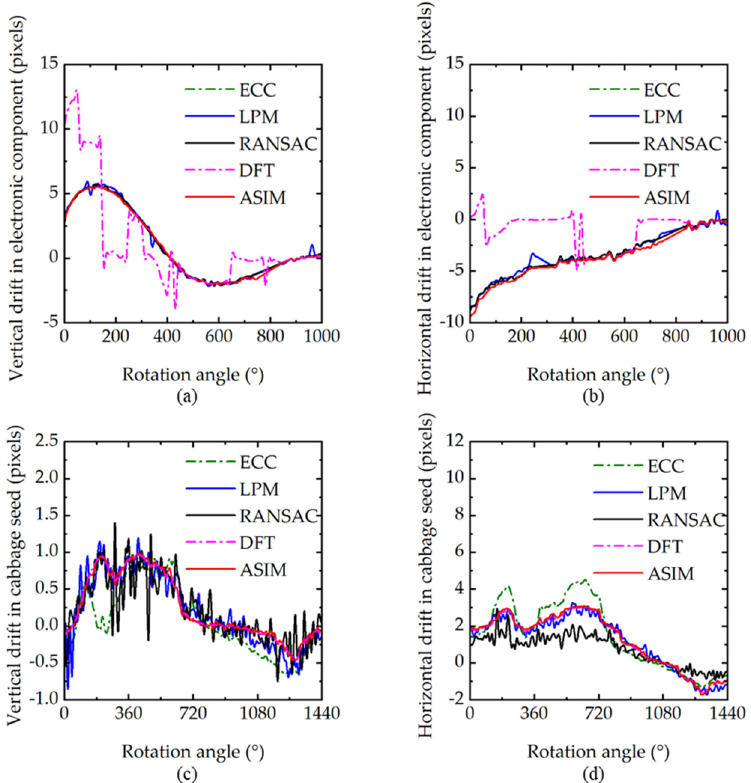
Figure 7. Drift calculation results. ( a , b ) Vertical and horizontal drifts in the electronic component scanning experiment, respectively. ( c , d ) Vertical and horizontal drifts in the cabbage seed scanning experiment, respectively.